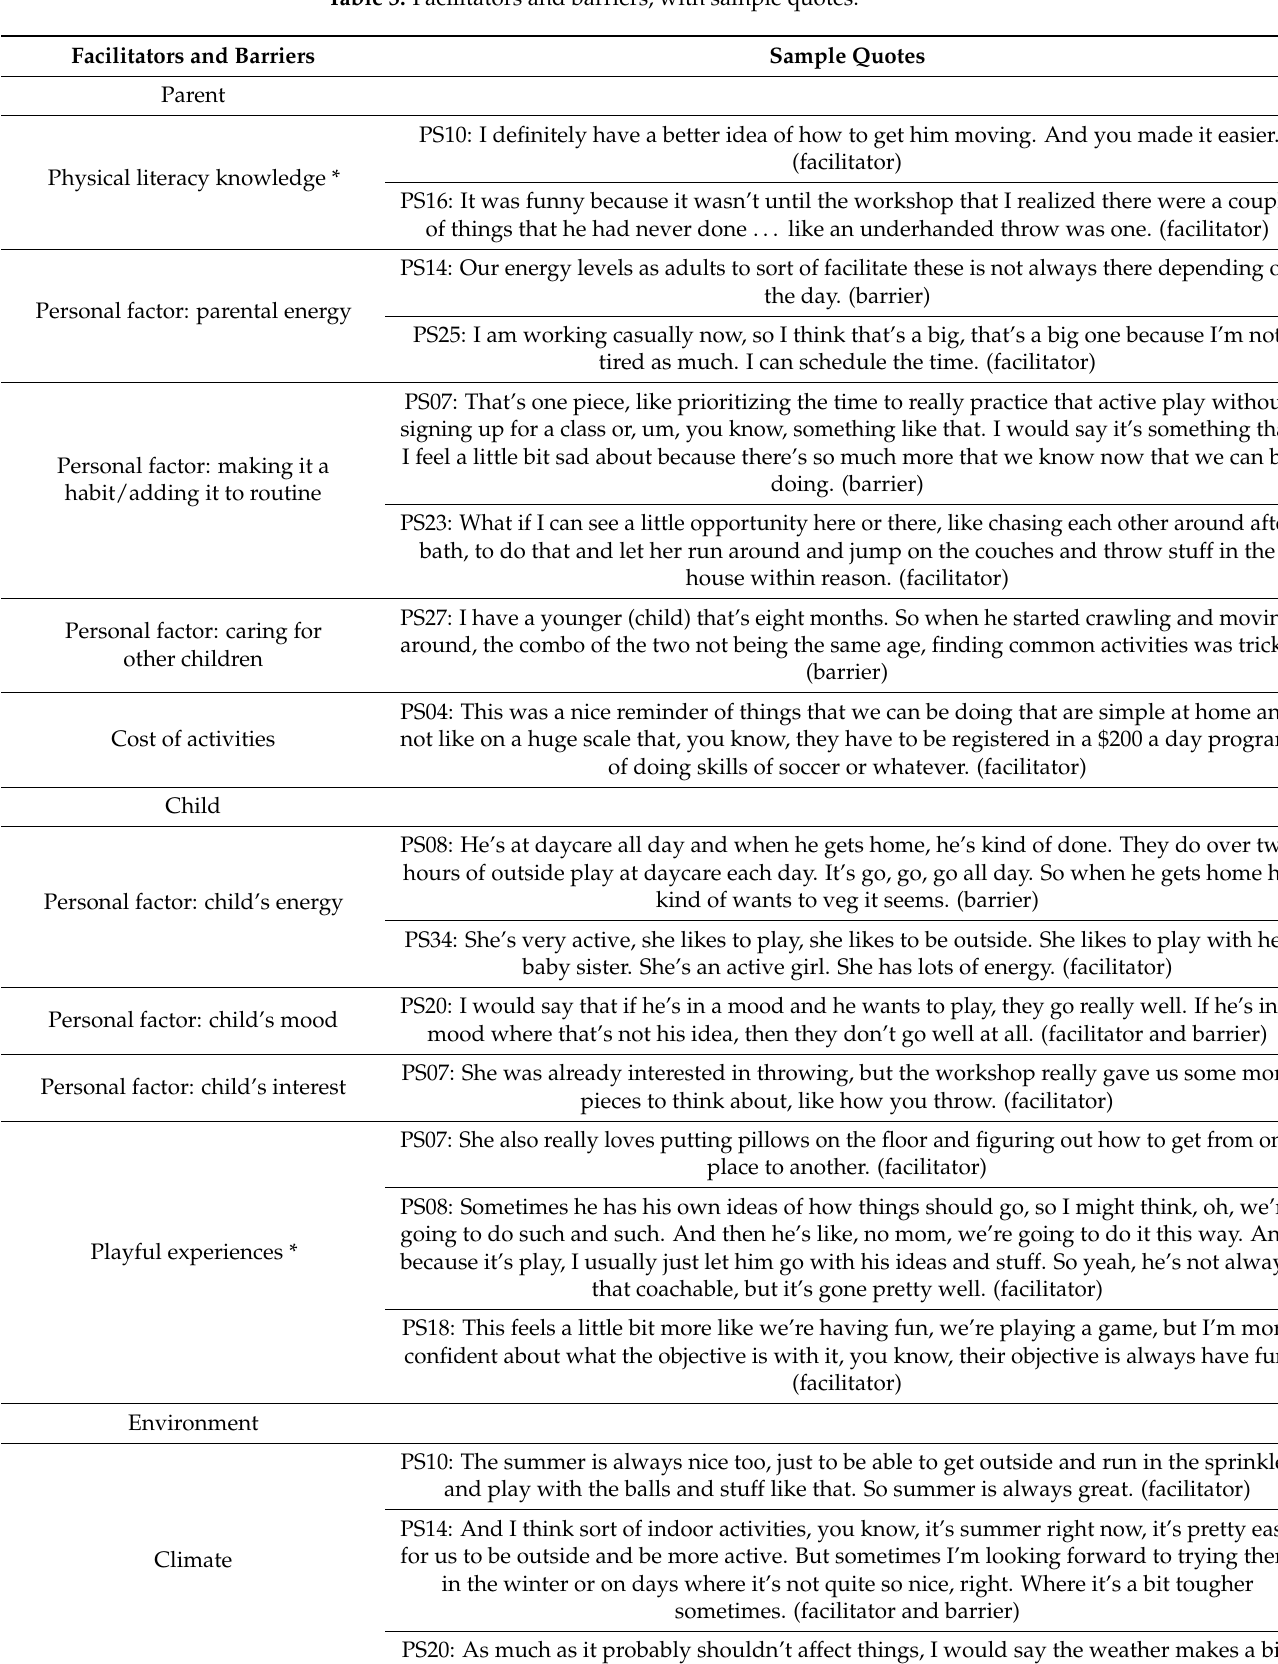
Table 3. Facilitators and barriers, with sample